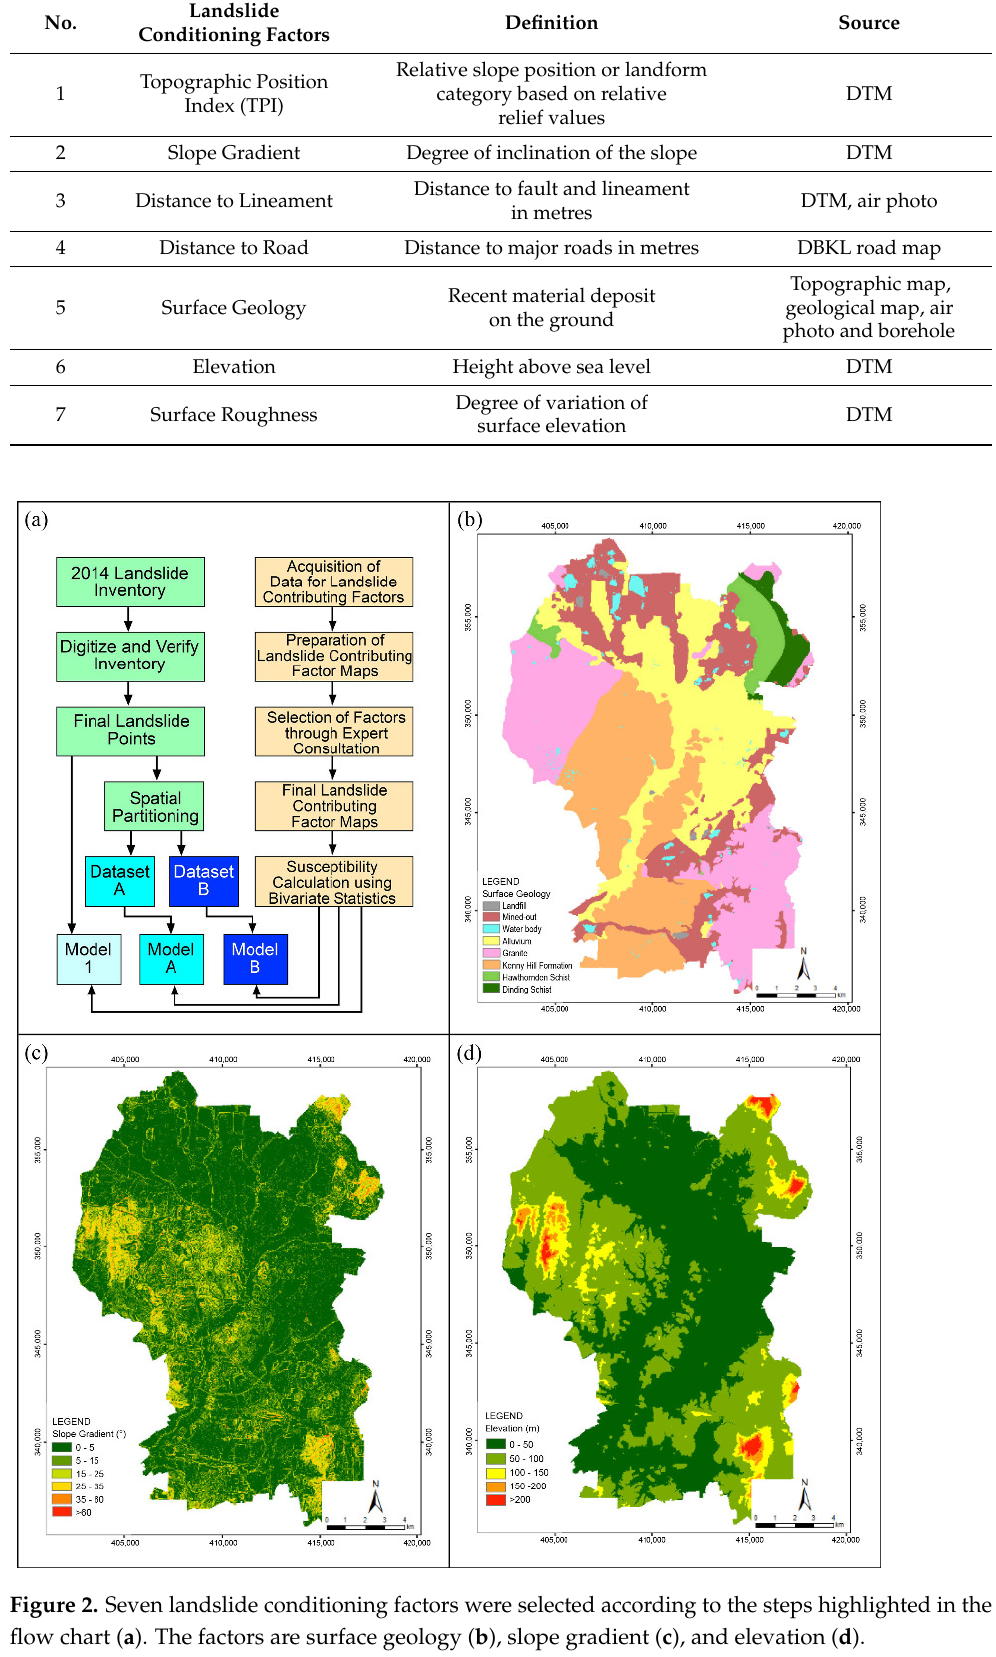
Table 1. Landslide conditioning factors and their definition as used in the bivariate statistical analysis.